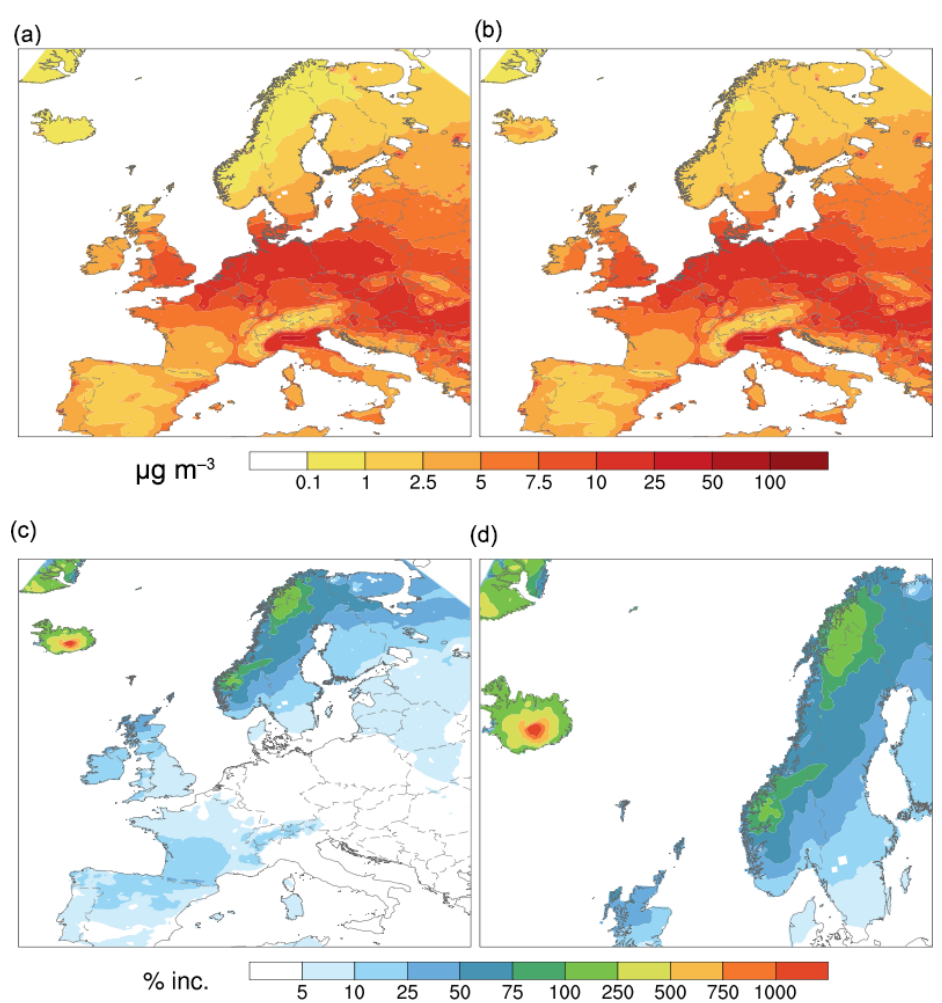
Figure 9. Shows the same as Fig. 8, but for average PM 2 . 5 concentration over the 3